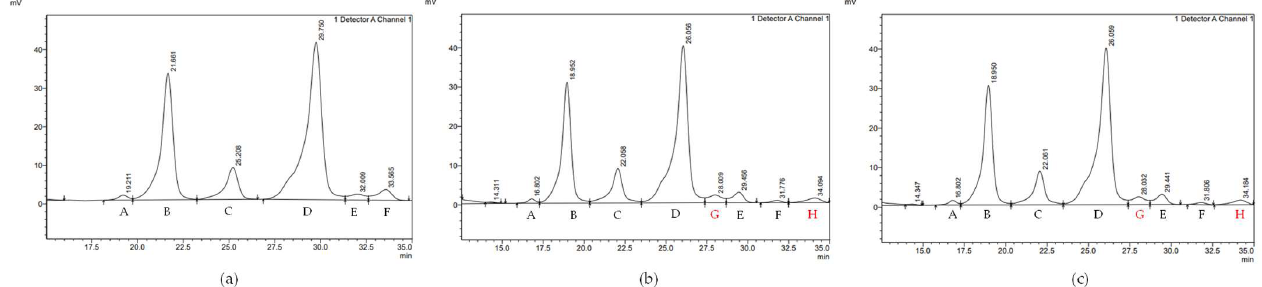
Figure 6. High-performance liquid chromatography analysis of ( a ) untreated 6% SBM, ( b ) hydrolysed 6% ( w / v ) SBM by immobilised endo-1,4- β -mannanase enzyme (9.14 U/mg), ( c ) hydrolysed 6% ( w / v ) free endo-1,4- β -mannanase enzyme (44.05 U/mg). Analysed using a Carbosep CHO 411 column, flow rate (0.26 mL/min), and a refractive index detector (RID). MOS standards were used to identify peaks of interest (M1–M6).